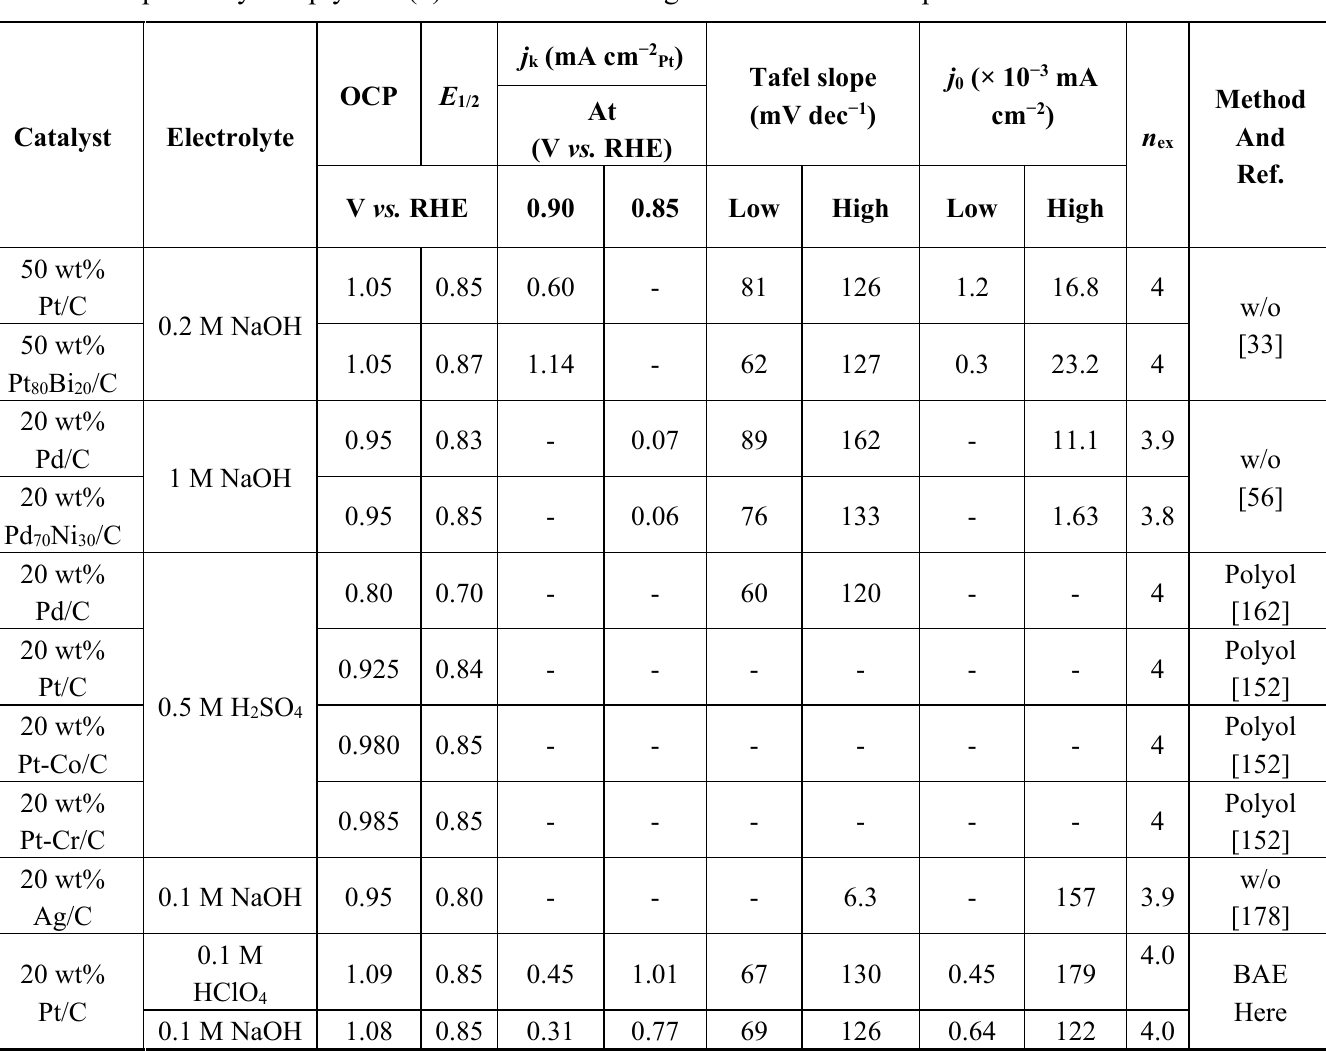
Table 1. Comparative performances of oxygen reduction reaction (ORR) results from RRDE experiments on various catalysts prepared from colloidal methods. E 1/2 was graphically determined at 1600 rpm (potential at i = I D /2). Note: OCP, “w/o” and “BAE” refer to open circuit potential, water-in-oil and bromide anion exchange methods, respectively. Empty box (–) means that the original article does not provide such data.